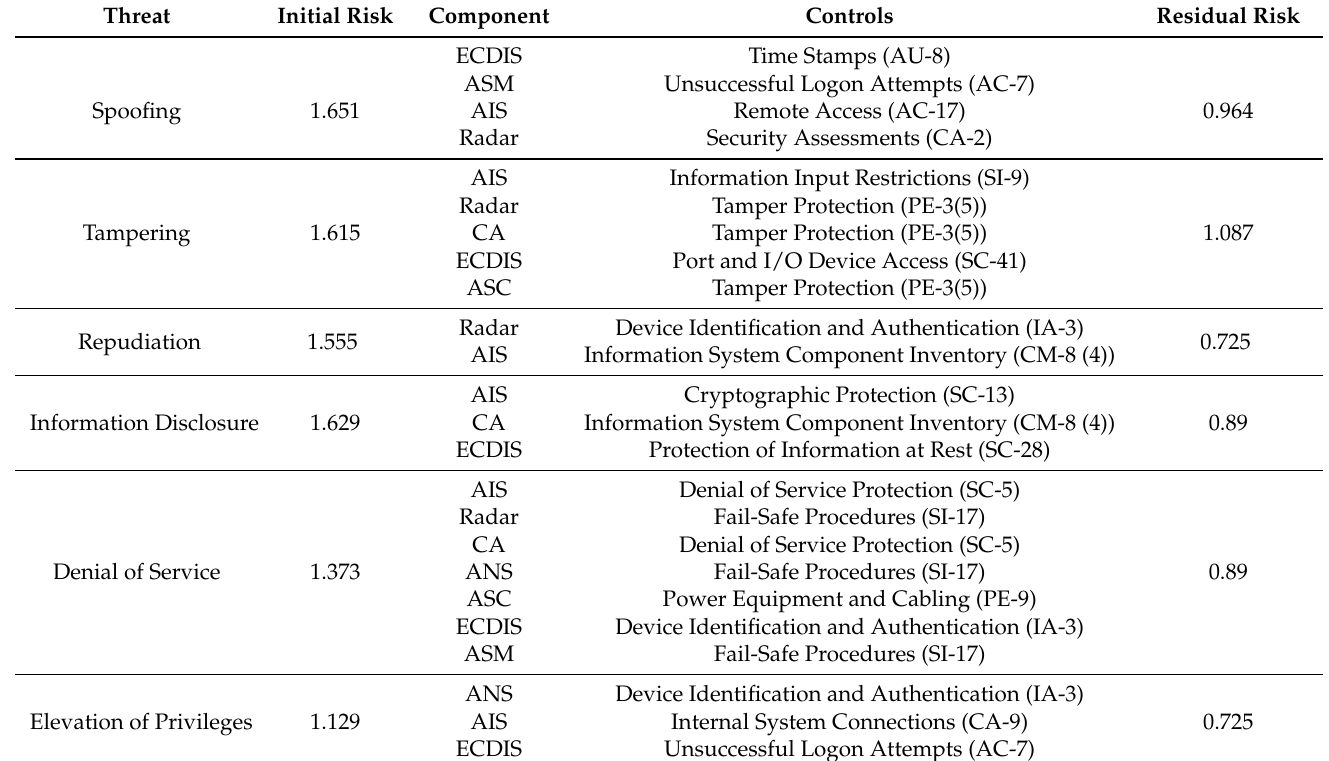
Table 5. Optimal controls—Autonomous